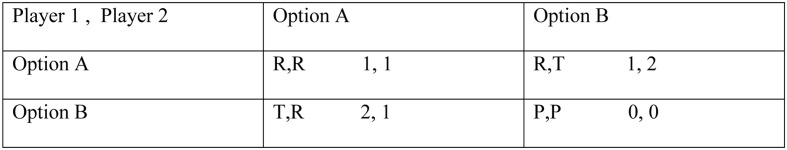
Payoff Matrix of the Volunteer’s Dilemma. Option A is to volunteer; Option B is to abstain.